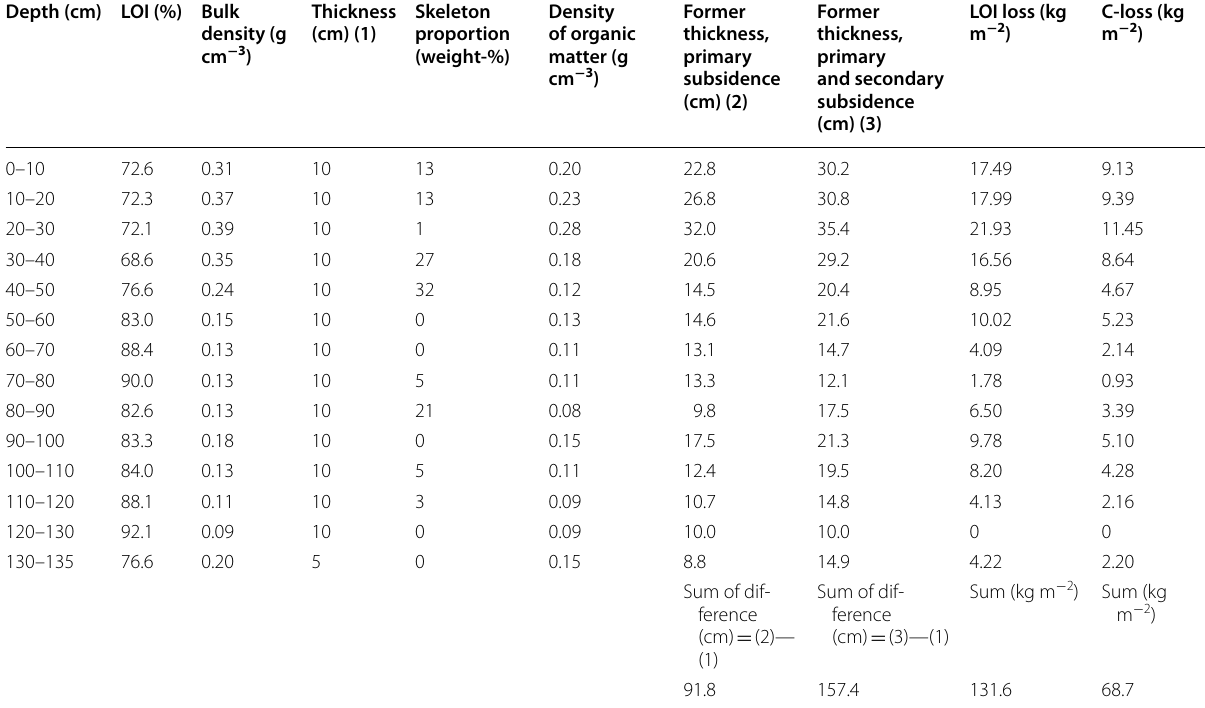
The average, annual C loss is calculated form the sum of C losses divided by 150 years (result